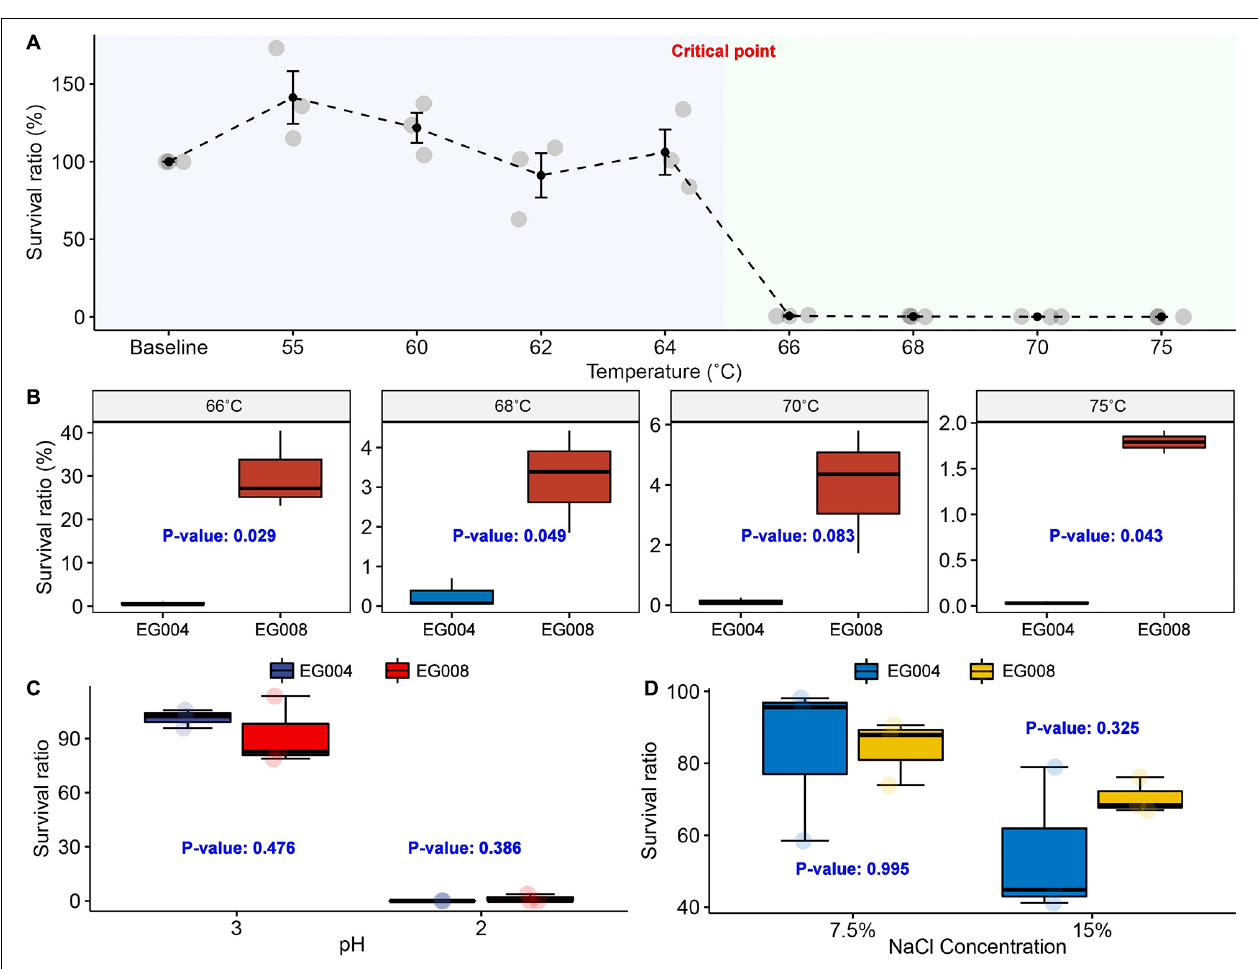
FIGURE 2 | Experiment to confirm improved thermal resistance at critical temperature above 66 ◦ C. (A) Survival curve of L. acidophilus EG004 strain under different temperature conditions. The survival rate was calculated after 1-min exposure at each condition, and three repeated trials were performed. At 66 ◦ C, a sharp drop in survival was observed. (B) The newly developed L. acidophilus EG008 strain showed an improved survival ratio compared to the EG004 at critical point above 66 ◦ C. P -value is the result of the two-group t -test. (C) Investigation of survival rate in acidic conditions. (D) Measurement result of change in survival rate according to salt